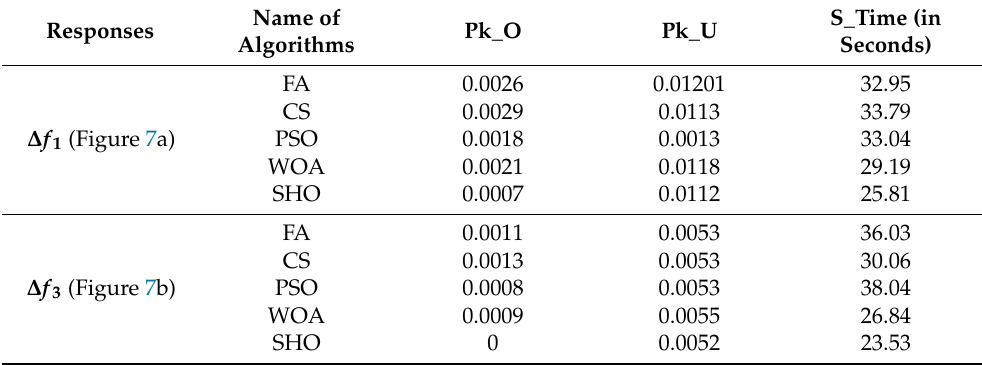
using FA/CS/PSO/WOA/SHO-optimized PDN(FOID) controller on an individual